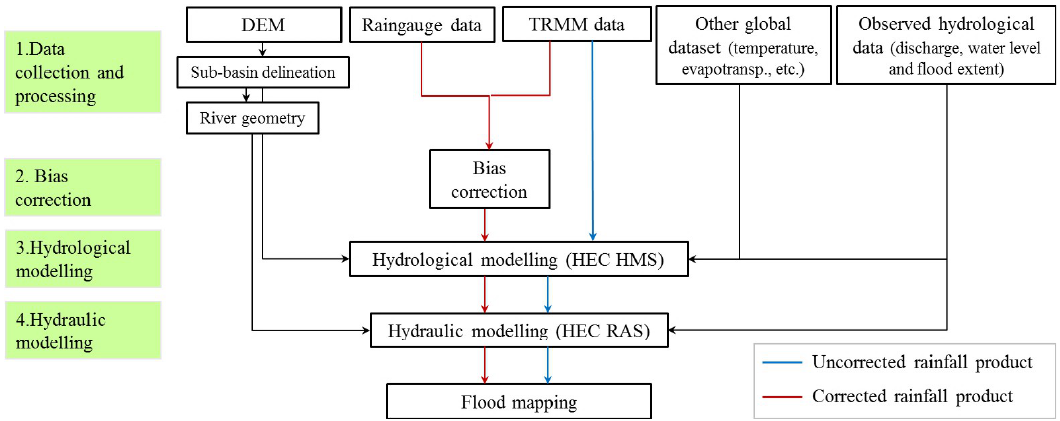
Figure 2. Methodological approach used in this study for assessing flood extent using global